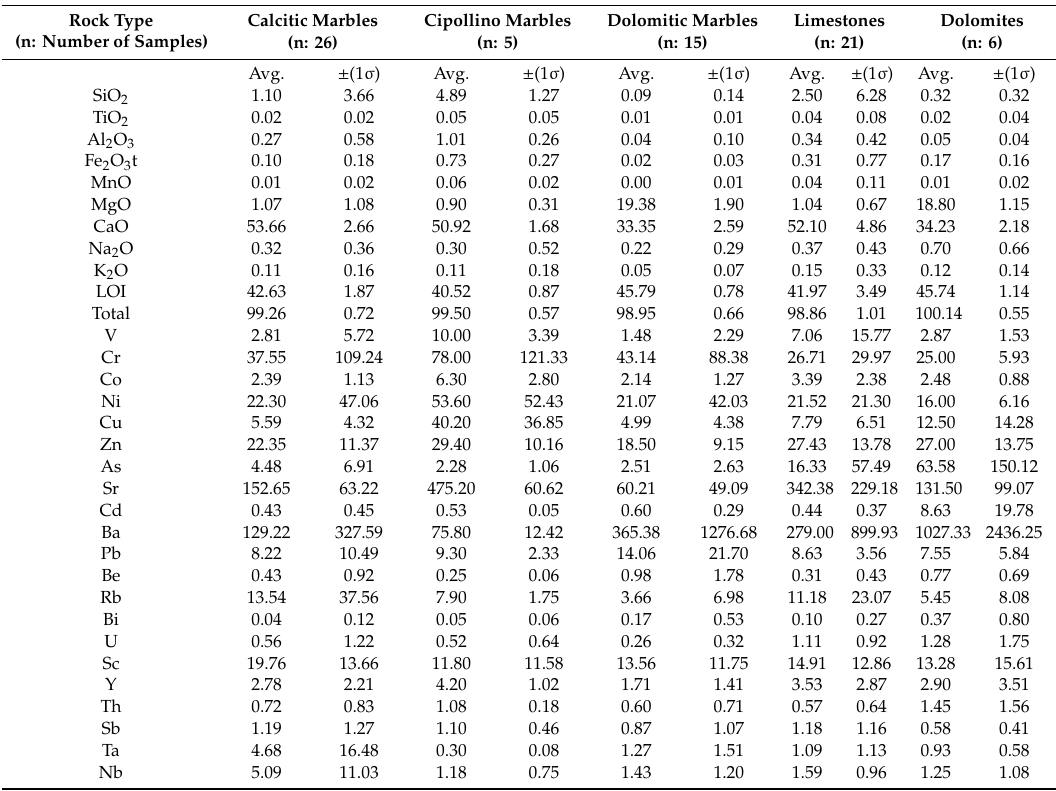
Table 1. Average whole rock major elements (wt.%) ± (1 σ ) and trace elements (ppm) compositions (from Table S1) of 73 carbonate ornamental stone samples from selected regions in Greece. Rock Type Calcitic Marbles Cipollino Marbles Dolomitic Marbles (n: Number of Samples)